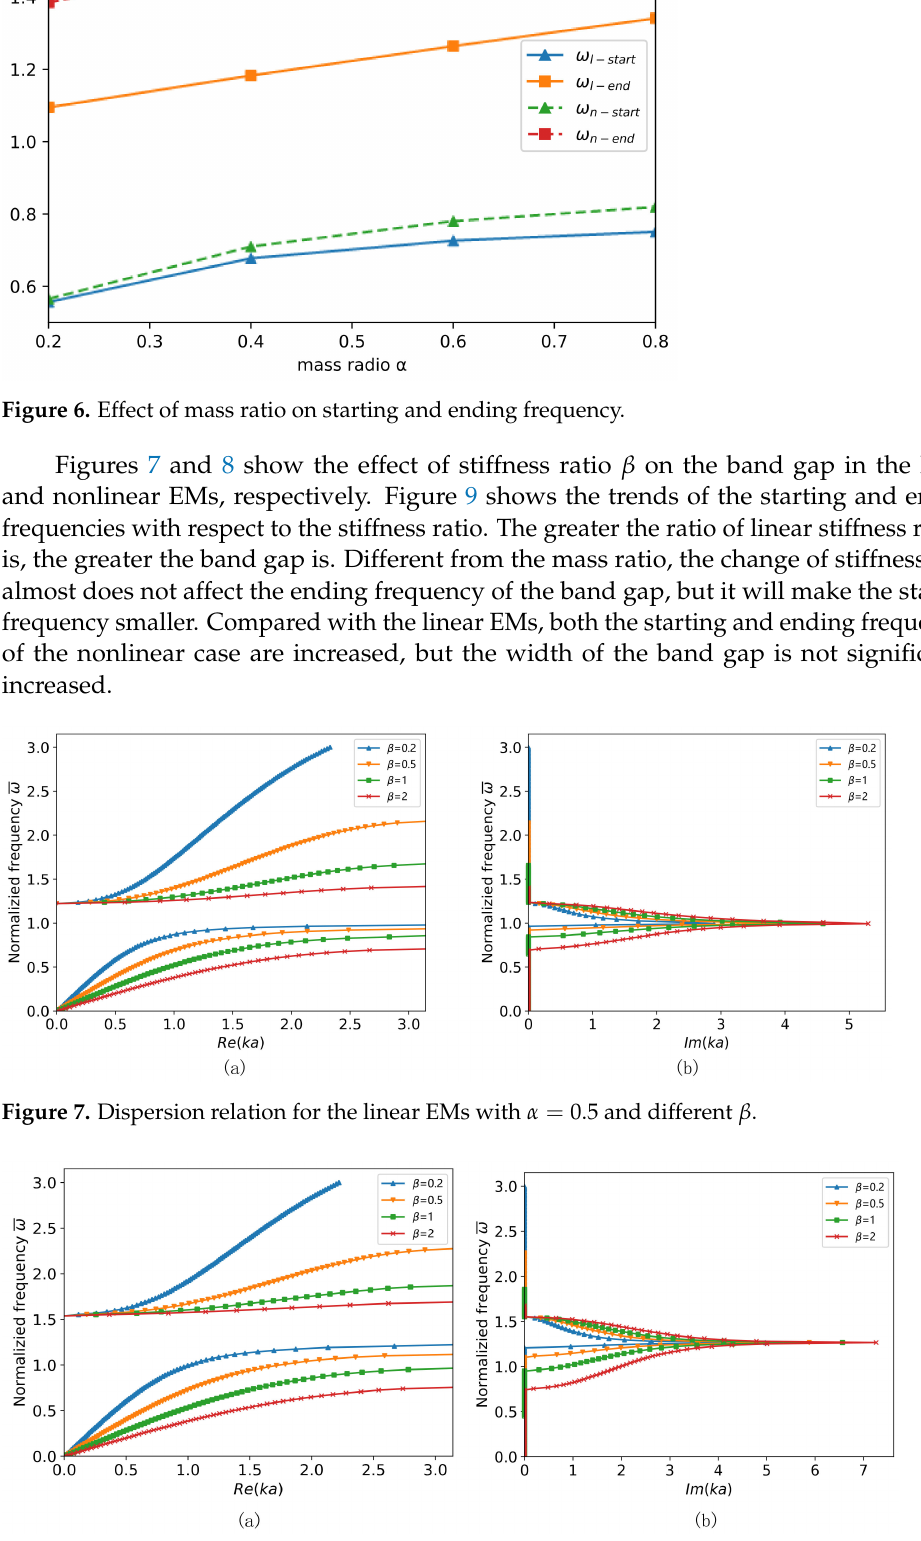
Figure 8. Dispersion relation for the nonlinear EMs with α = 0.5, γ A 1, n A 1, n = 0.2 and different β